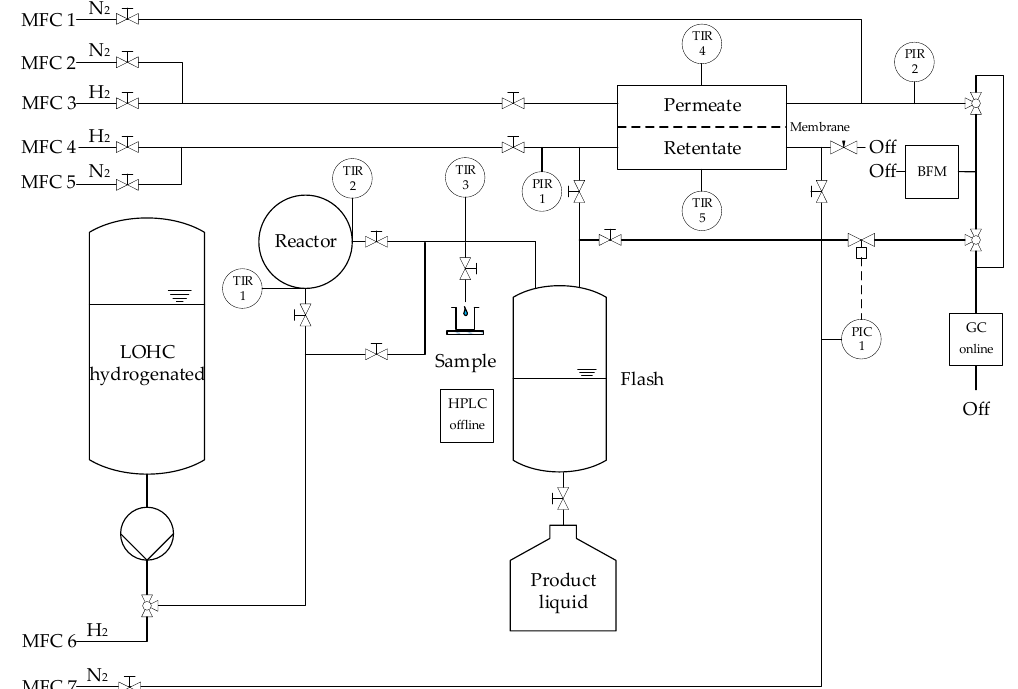
Figure 5. Flow diagram of the lab plant for the coupled release and purification of hydrogen.